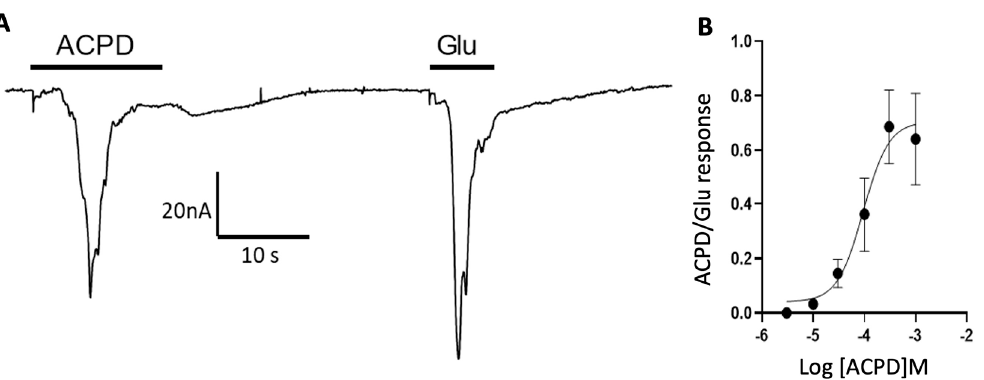
Figure 2. Oscillatory responses are mediated by Group 1 mGluRs. ( A ) Representative ion currents elicited by 100 µM ACPD and 1 mM Glu in the same microtransplanted oocyte. ( B ) Concentration response curve for ACPD normalized by the maximum amplitude of the response elicited by 1 mM Glu in each oocyte (each point represents the mean ± S.E.M from 4 to 13 oocytes tested for each concentration).